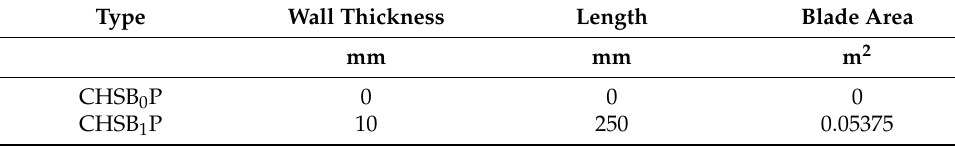
Table 3. Pile material